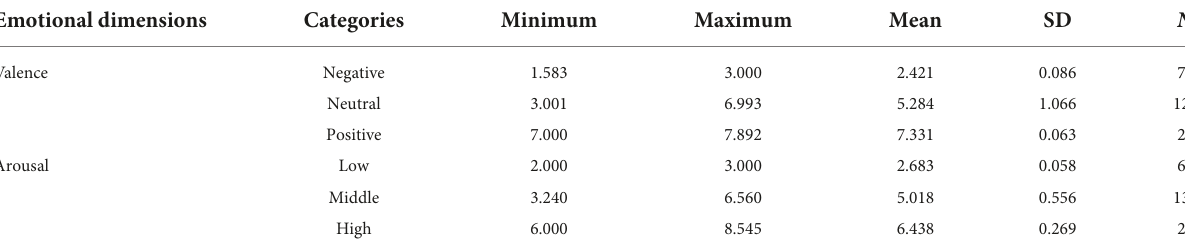
TABLE 4 Consistency between Expert 1 and Expert 2 in judging emotional valence & arousal ( ≥ 75%).